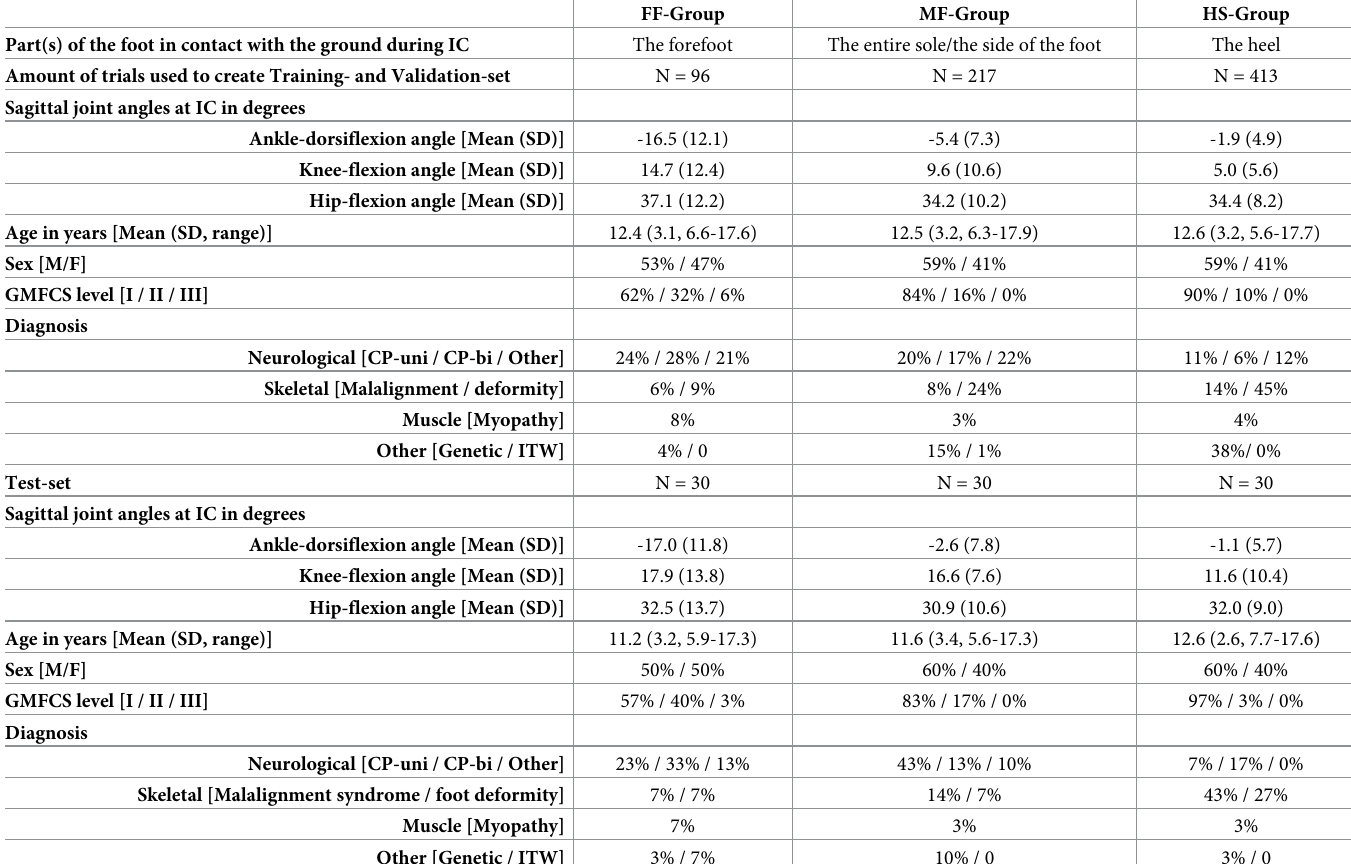
Table 1. Participant description.